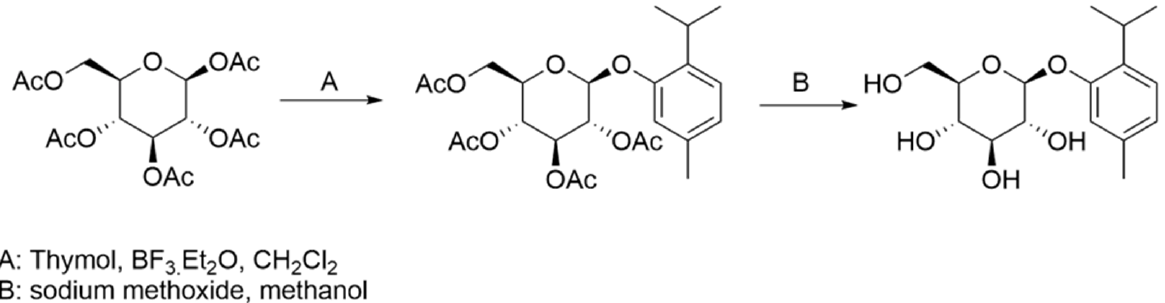
Figure 5. Synthesis of thymol derivatives.